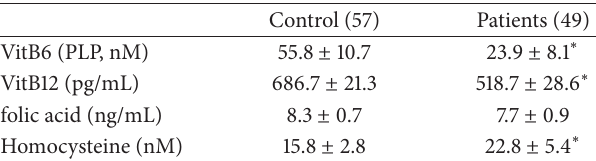
Table 3: The levels of serum VitB6, homocysteine, folate, and VitB12 in patients with fatty